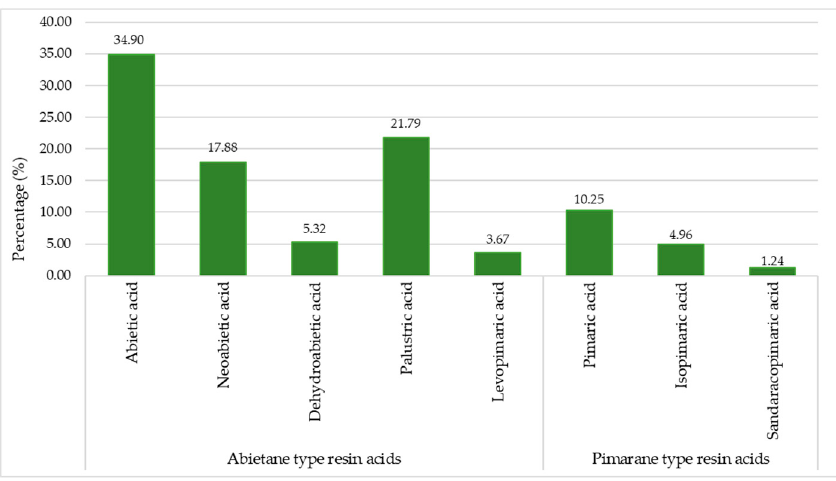
Figure 3. The mean percentage of abietane and pimarane types of resin acids.